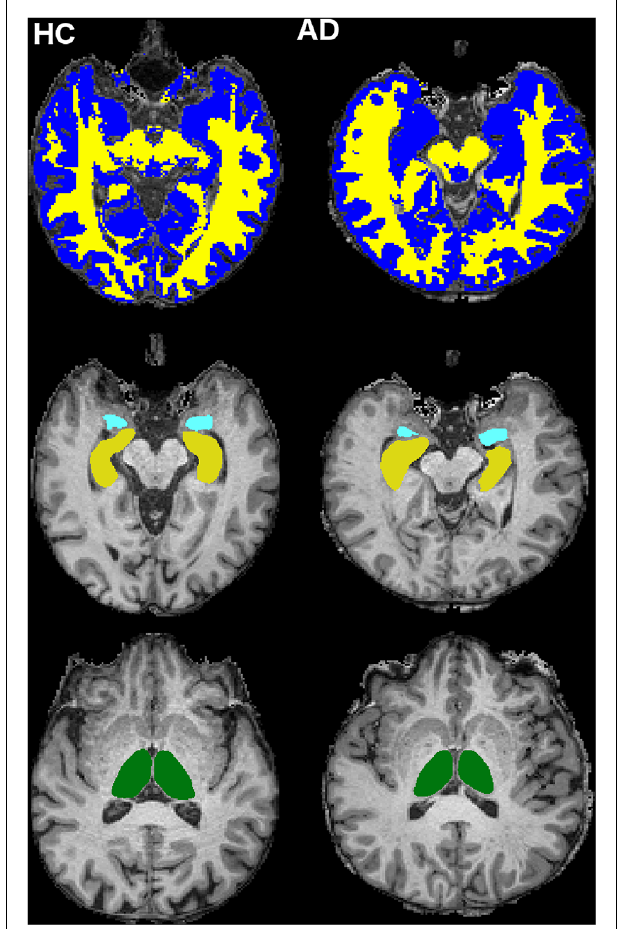
FIGURE 2 | Cerebral tissue segmentation in two randomly chosen subjects: HC subject on the left and AD patient on the right. Top row: white matter (WM; yellow) and gray matter (GM; blue) segmentation (slice n = 126, transverse plane). Middle row: hippocampi (yellow) and amygdalae (light blue) segmentation (slice n = 123, transverse plane). Bottom row: thalami (green) segmentation (slice n = 132, transverse